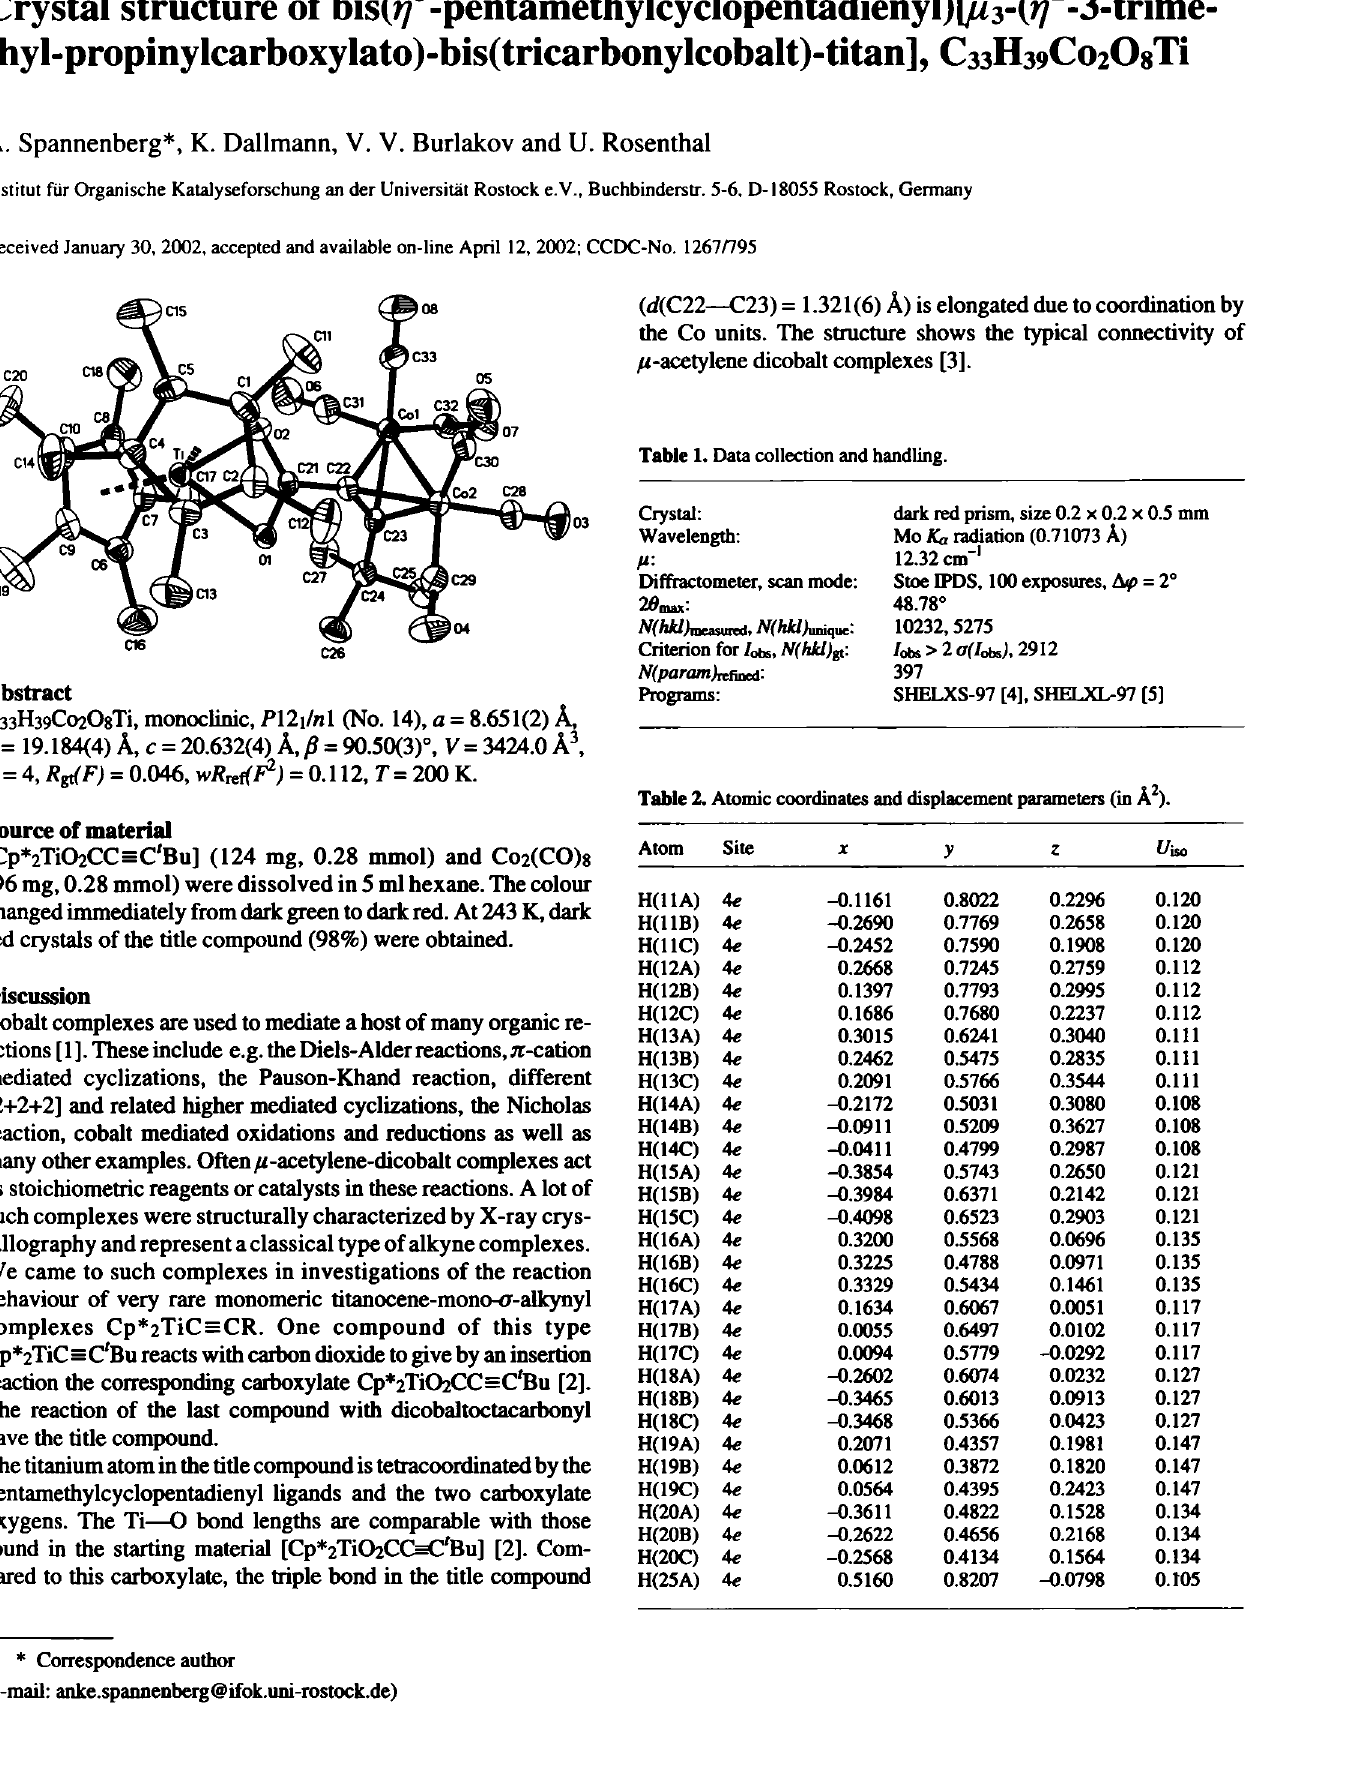
Table 1. Data collection and handling. Crystal: